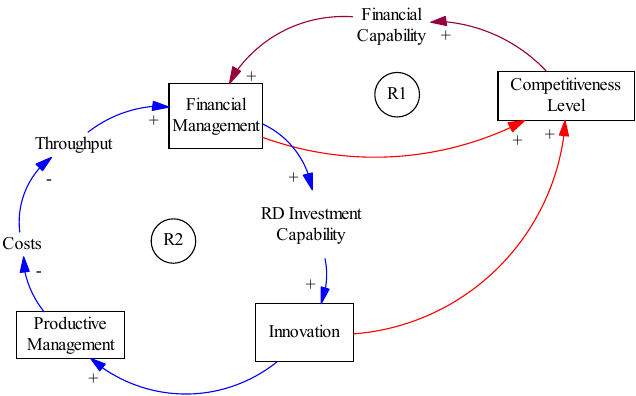
Figure 4. R1 and R2 Cycles: Financial Management, Innovation, Productive Management, and Competitiveness Level.